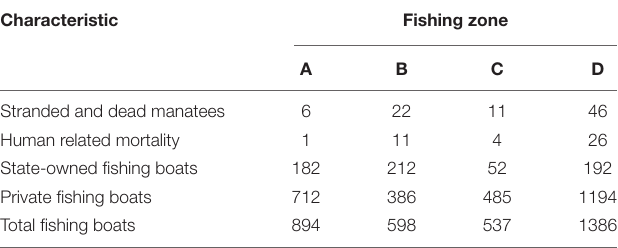
TABLE 5 | Numbers of mortalities for each of the codes for the six parameters that characterize contemporary events affecting manatees in Cuba across the five groups of events generated in the SIMPROF